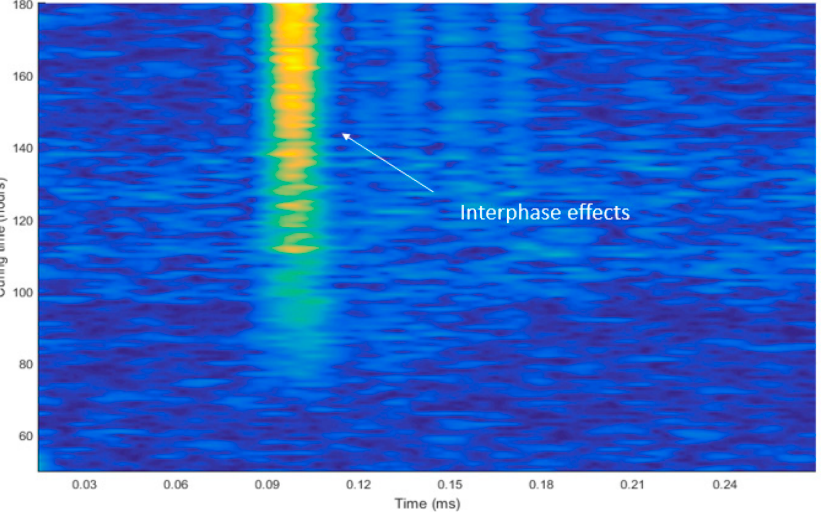
Figure 7. Phase-change response in signals propagation.